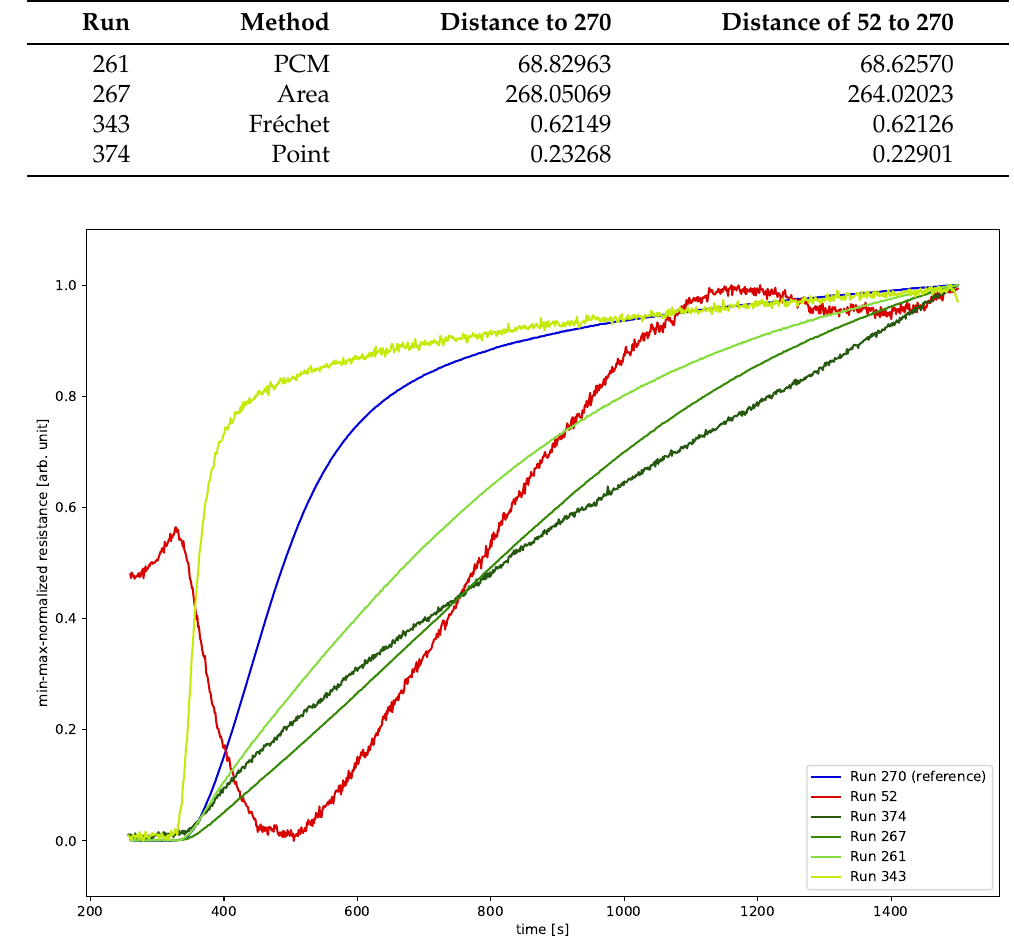
Figure 5. Curve similarity of a subset of test curves with respect to the reference run 270 (blue). The curve of run 54 (red) yields a different signature ( ´`´`´` ) to the other curves (green) ( ``` ) which is therefore filtered out although it has very similar distances (see Table 3) to the remaining curves.